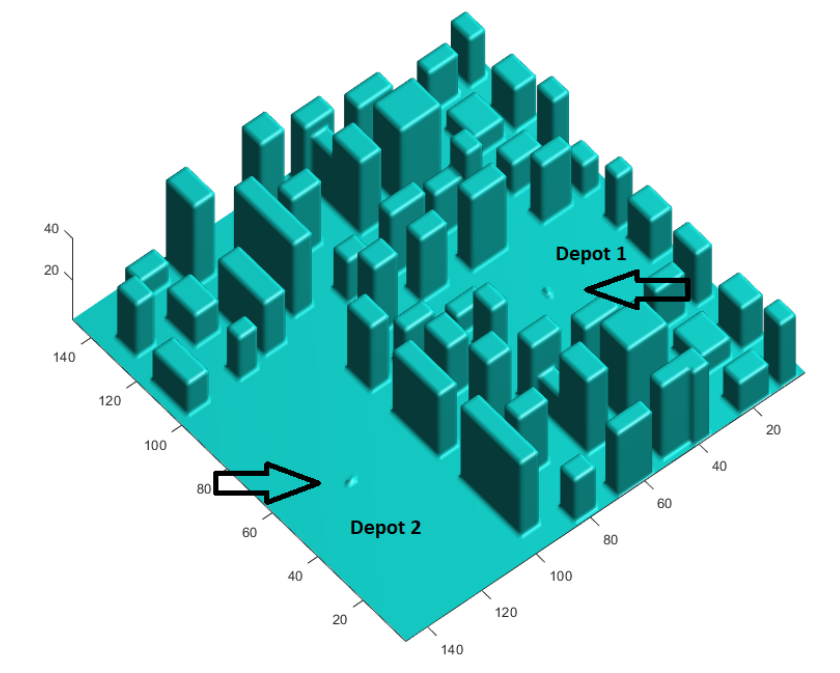
Figure 1. Simulated urban environment used for the tests performed in this